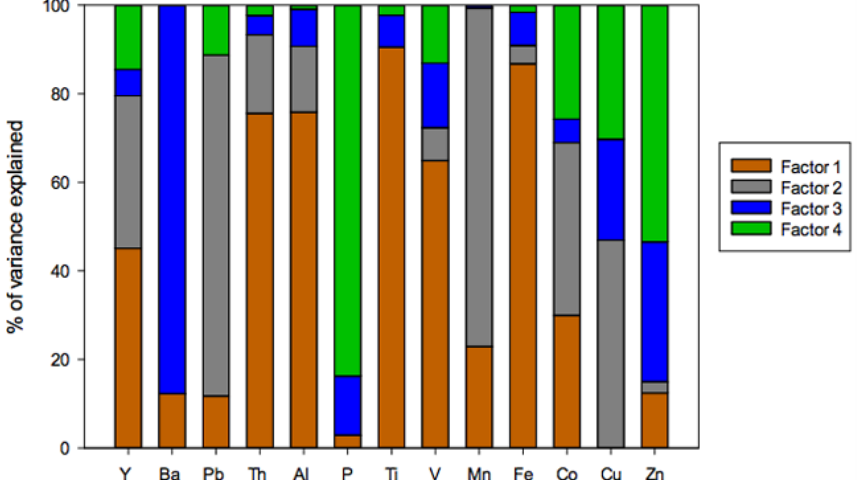
Figure 5. Factor fingerprint of the positive matrix factorization conducted on 445 particle samples collected along the GA01 section. The four main factors influencing the particulate trace element variance are represented in a stacked bar chart of the percentage of variance explained per element. Factor 1 is dominated by the lithogenic elements, e.g. Th, Al, Ti, and Fe. Factor 2 is associated with Pb and Mn variances. Biogenic barite formation mainly influences factor 3. Factor 4 is dominated by biogenic elements, e.g. P, Co, Cu, and Zn.